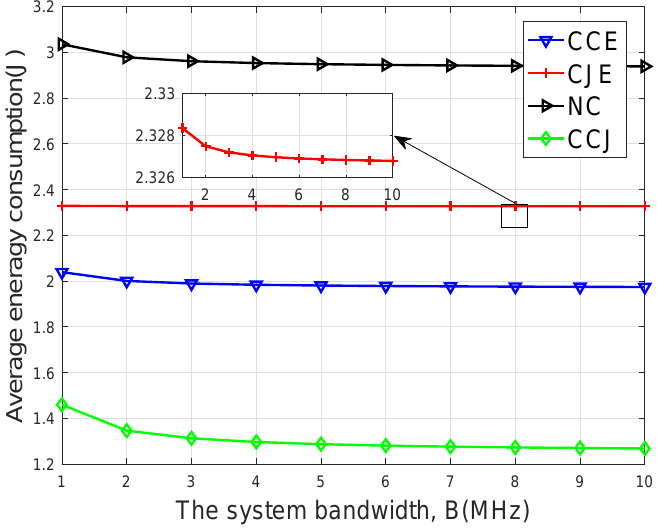
Figure 5. Average energy consumption on the four schemes versus the system bandwidth B